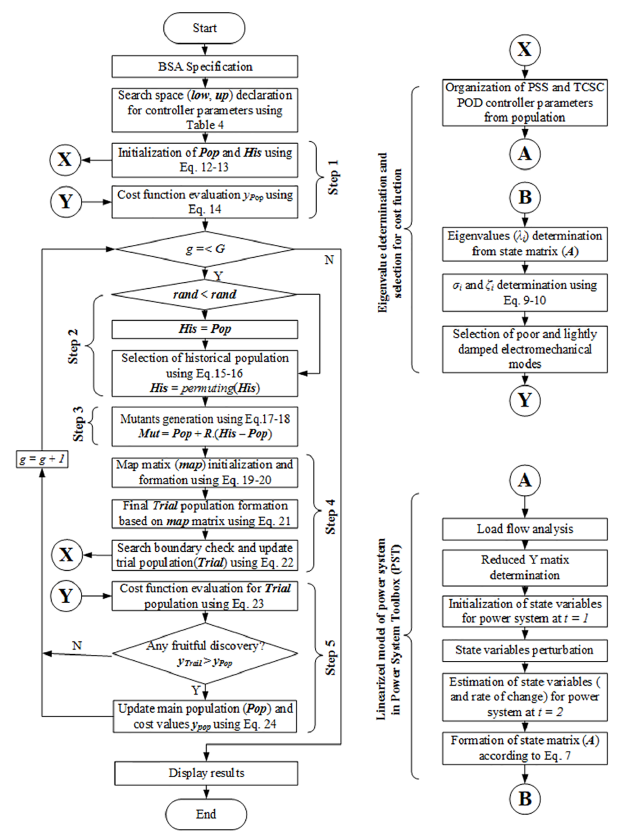
Fig 6. BSA implementation block diagram for the coordination design of the PSS and TCSC